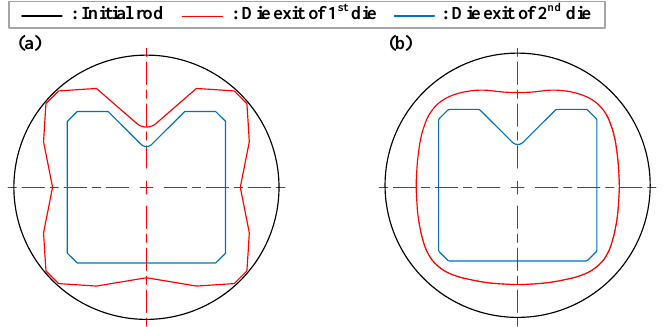
Figure 9. Cross-sectional shapes of the two-pass shape drawing dies: ( a ) ERV method; ( b ) equipotential line method.